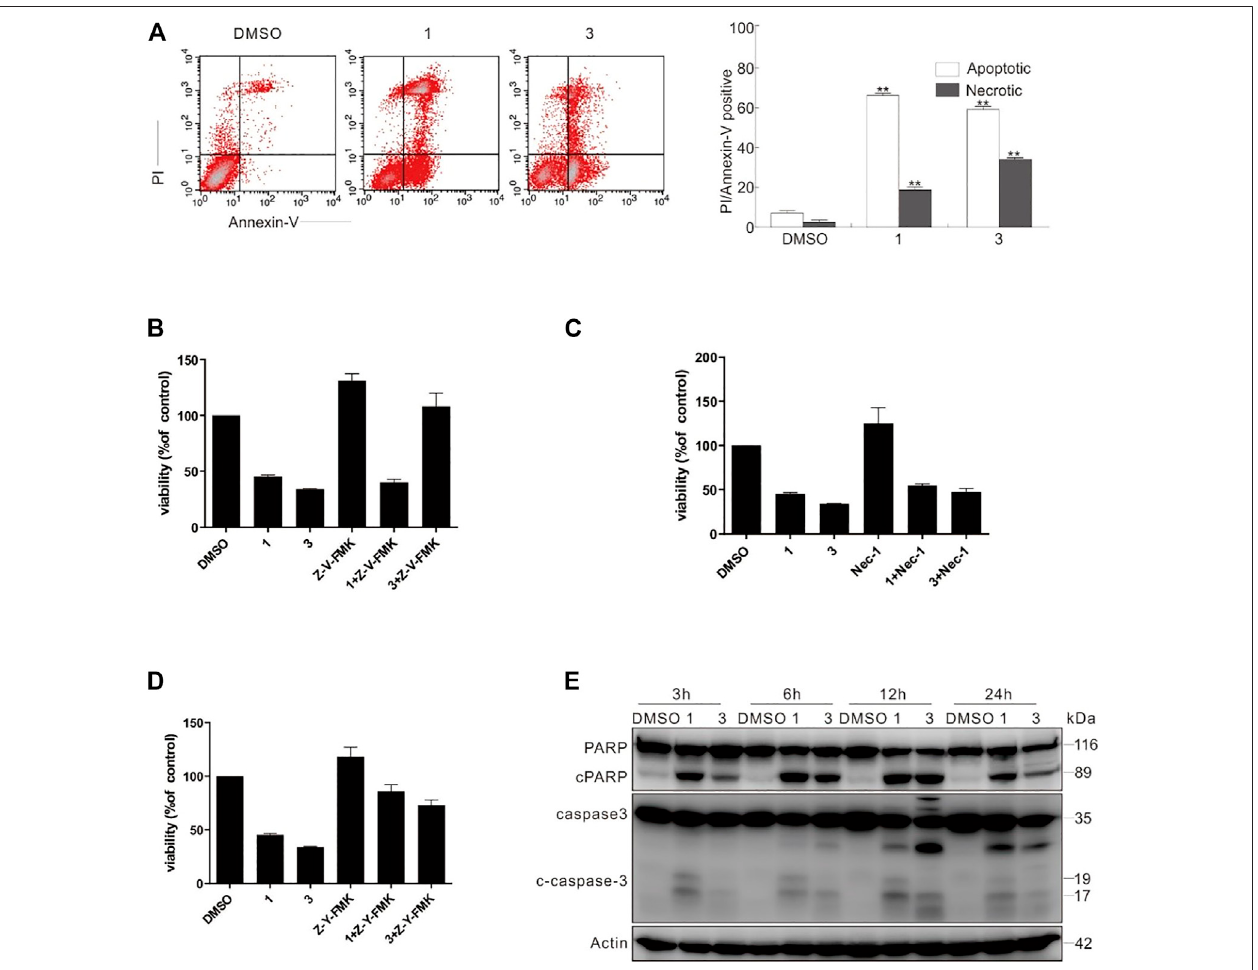
FIGURE 11 | Compounds 1 and 3 activated caspase-dependent apoptosis. (A) Following treatment of SW480 cells with compounds 1 and 3 (20 μ M) for 6 h, the induced apoptosis and necrosis were determined by fl ow cytometry. Apoptotic: AV-positive and PI-negative; necrotic: PI-positive. (B – D) SW480 cells were challenged withcompounds 1 and 3 withorwithoutZ-V-FMK(20 μ M)orNec1(30 μ M)orZ-Y-FMK(25 μ M)for12 h,anddetectionofcellviabilitywascarriedoutbyMTSassay. (E) The SW480 cells were treated with compounds 1 and 3 (20 μ M) upon to 24 h, and then cell lysates were prepared and analyzed by immunoblotting using the indicated antibodies; actin was used as a loading control. The image represented quanti fi cation of the signals ( n = 3). For the results of histogram, the data of as mean ± S.D. presented and analyzed by T -test. * p < 0.05 vs. control; ** p < 0.01 vs. control. Similar experiments were performed at least three times.